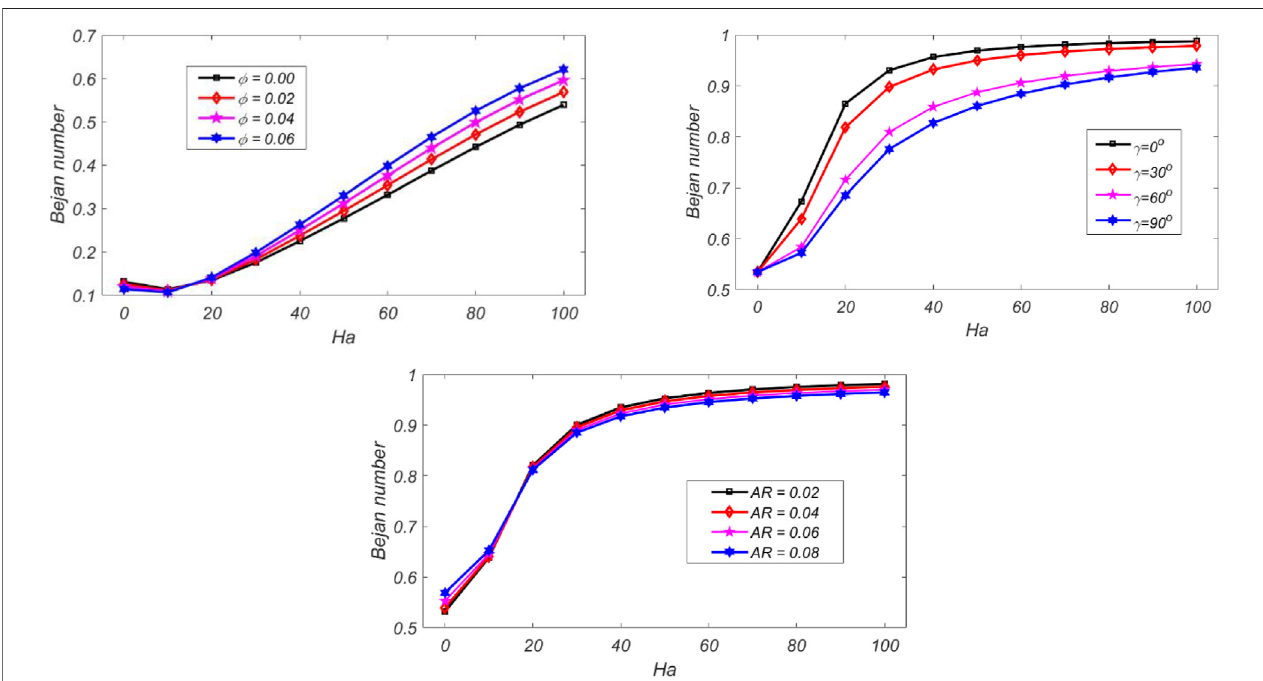
FIGURE 7 | Impacts on Be against Ha for different parameters.